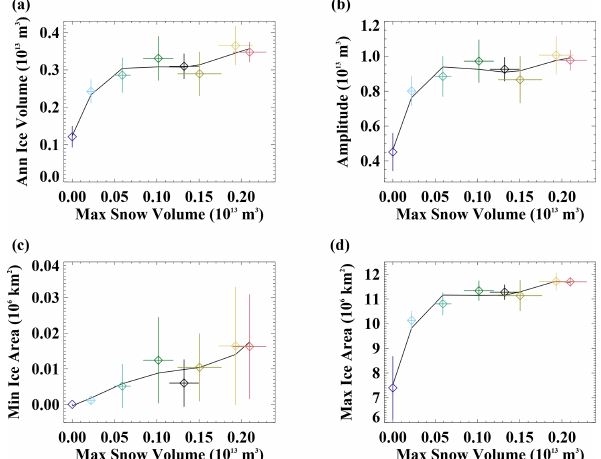
Figure 12. The relationship in the 2xCO2 simulations of the cli- matological Northern Hemisphere (a) annual ice volume, (b) am- plitude of the ice volume annual cycle, (c) annual minimum ice area, and (d) annual maximum ice area versus the annual maximum snow volume. The diamonds show the simulated mean values, and whiskers are ± 1 standard deviation with the colors the same as in other figures. The black line is a fourth-order polynomial